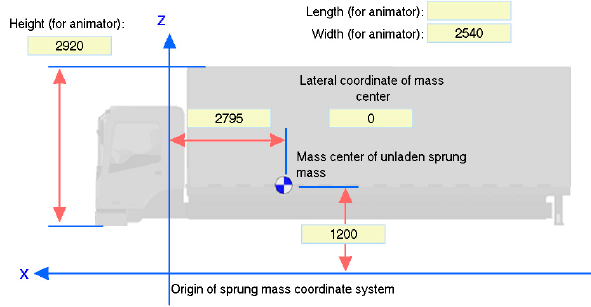
Figure 13. High-precision model of AWEB.